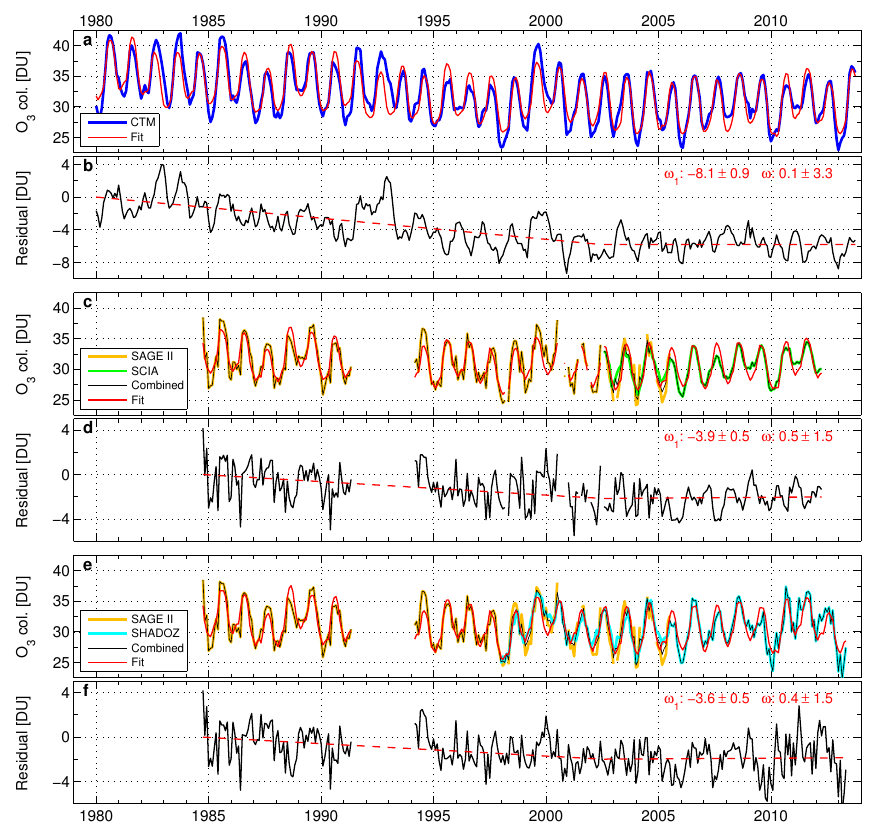
Figure 3. Regression analysis of observed and simulated O 3 partial columns. Model is combined SAGE II/SCIAMACHY and combined SAGE II/SHADOZ LS O 3 with regression function ( a , c , e ). Corresponding fit residuals excluding the linear terms ( b , d , f ). The dashed red lines depict the resulting linear trends before and after 2002 with the fit coefficients in red font (unit: % per